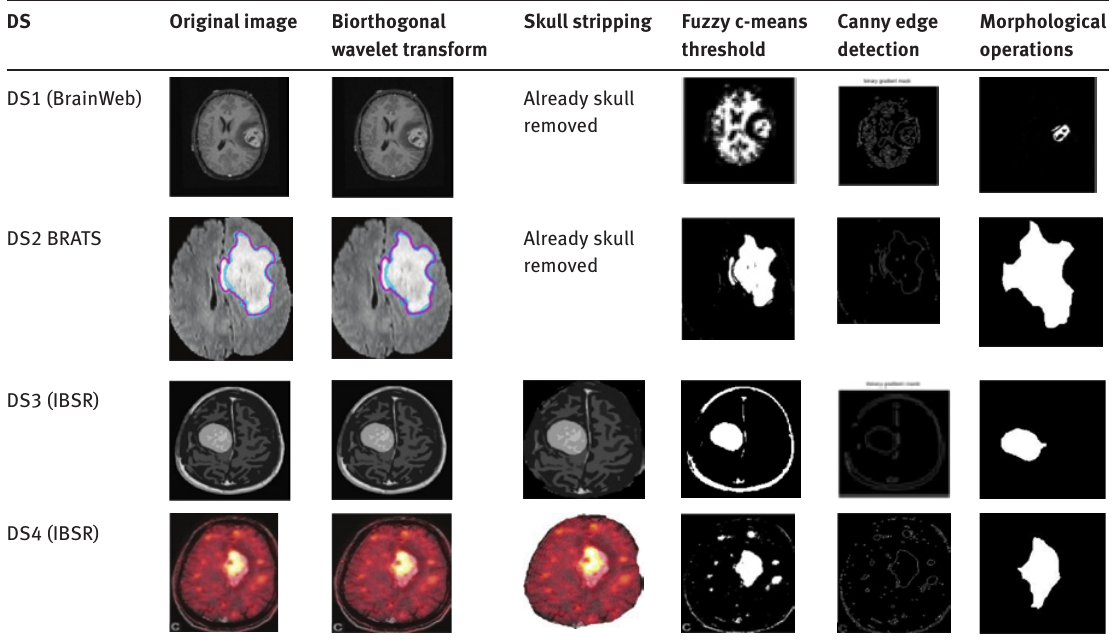
Table 3: Results of Various Steps of the Proposed Framework Applied on Three Different